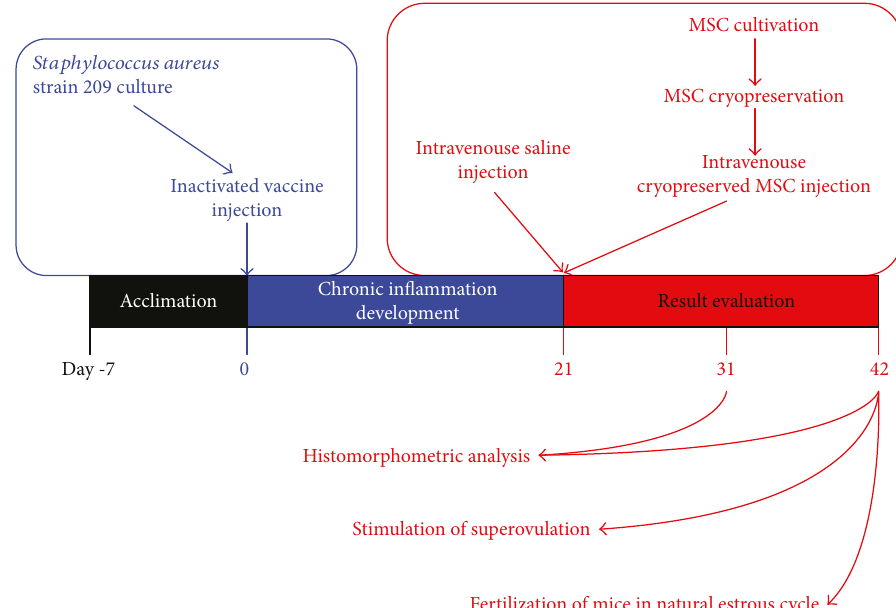
Figure 1: Experimental schedule. Mice were acclimated for at least 7 days prior to experiments. Then, they were intraperitoneally injected with inactivated vaccine of Staphylococcus aureus to simulate the chronic in fl ammation of ovaries. 21 days later, control animals were intravenously injected with saline solution and experimental ones were intravenously injected with cMSCs. The results were evaluated on the 10th and 21st days after therapy (31st and 42nd days of